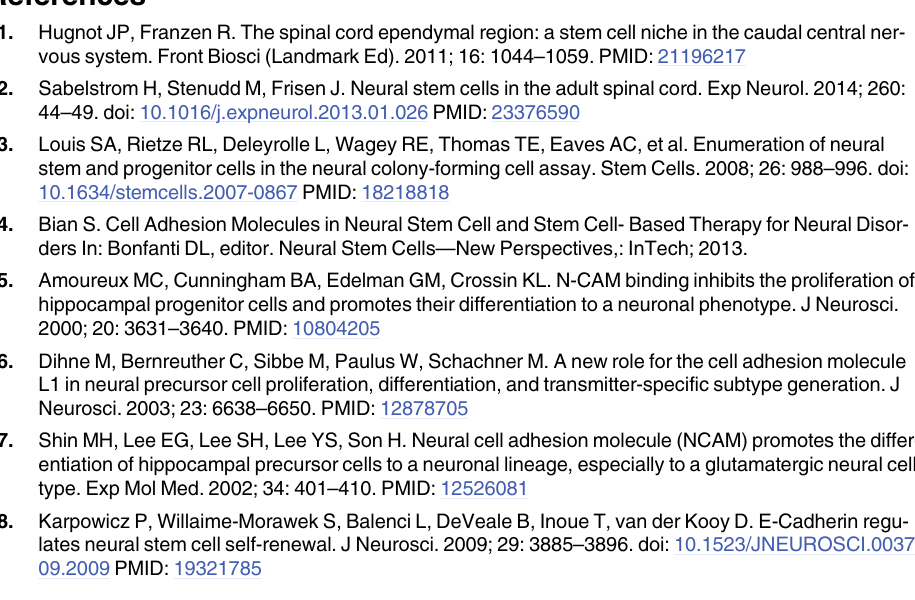
S1 Fig. Original detection of OCAM expression in embryonic spinal cord neurosphere cells. ( A ): Gene arrays specific for cytokines and adhesion molecules (purchased from R&D) were probed with cDNAs derived from growing (red) and differentiated (green) neurospheres as described in [12]. OCAM as well as VCAM1 mRNA were readily detected in both culture conditions. ( B ): High magnifications of OCAM spots. (TIF) S2 Fig. OCAM expression during spinal cord development and in the adult central canal stem cell niche. ( A ): Expression of OCAM detected by immunofluorescence in the embryonic spinal cord. ( B ): High magnification of OCAM staining at E13.5. V = ventricle. ( C ): Immunode- tection of Sox2 in E13.5 spinal cord. V = ventricle. C ’ , C ” : Examples of double positive Sox2 + OCAM + cells in the ventricular zone. ( D ): Immunodetection of Map2 in E13.5 spinal cord. D ’ , D ” : Examples of double positive Map2 + OCAM + cells in the mantle zone. ( E ): Immunodetec- tion of OCAM in ependymal cells surrounding the central canal in adult mice. Left : OCAM is weakly expressed in the dormant niche. Right : 72h after spinal cord injury, OCAM is readily de- tected. Left and right images were taken with the same exposure time. ( F ): Detection of OCAM RNA by microarray analysis (top) (n = 4) or QPCR (bottom) (n = 4). Scale bars = 10 μ m.